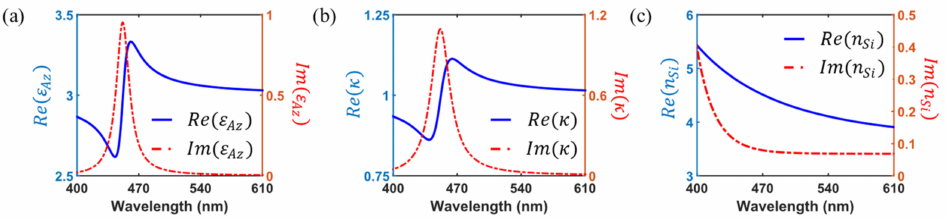
Figure 2. The real and imaginary parts of ( a ) ε Az , ( b ) κ and ( c ) n Si as a function of wavelength, respectively.